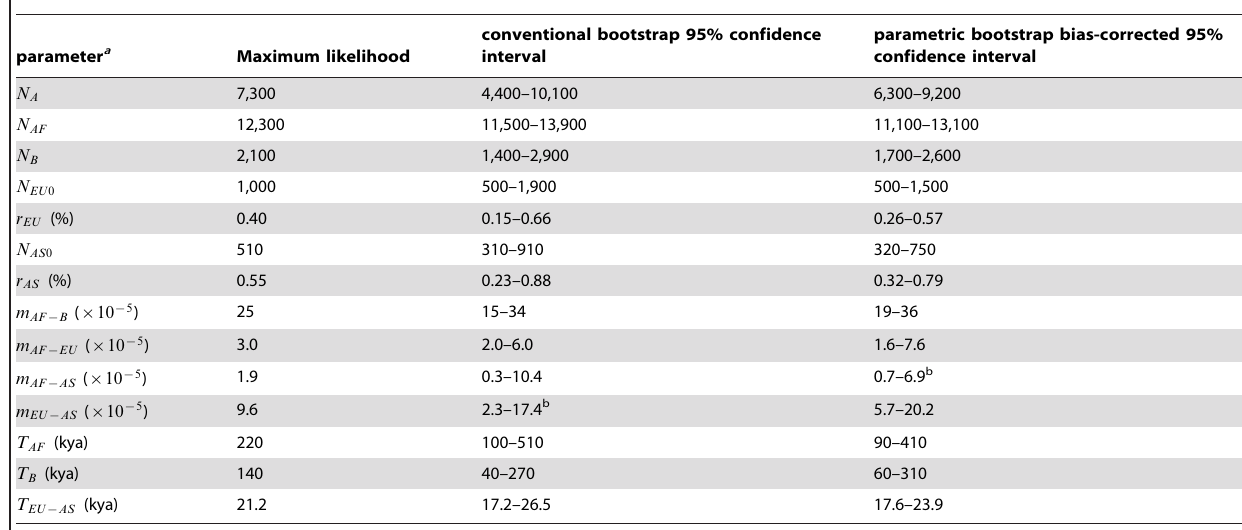
Table 1. Out of Africa inferred